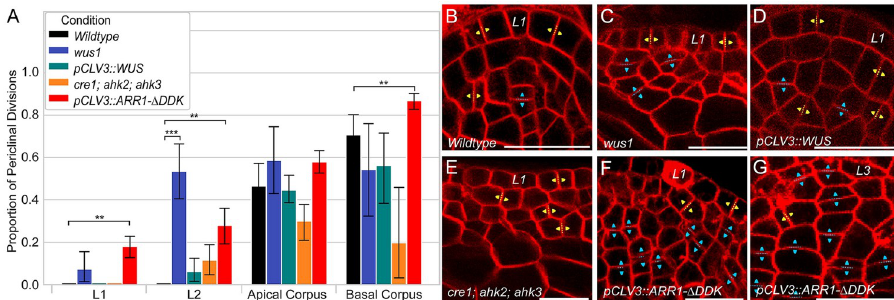
Fig 4. Layer-specific organization of cell division plane orientation. (A) Periclinal and anticlinal divisions were quantified by cell layer on a minimum of 10 SAMs (see S1 Appendix for details). Significance tests were performed using independent t-tests. Asterisks indicate significance at the following levels: �� (p � 0.01), ��� (p � 0.0001). Higher magnification median longitudinal section from Fig 2 showing (B) wildtype [l er ], (C) wus1–1 , and (E) cre1–12; ahk2–2;ahk3–3 vegetative meristems. 48 hour Dex induction of (D) ectopic misexpression of WUS [pCLV3::LhG4; 6xOP::eGFP-WUS-GR] and (F) ectopic misexpression of CK signaling [pCLV3::LhG4; 6xOP::ARR1 - Δ DDK-GR] . (G) Characteristic “strips” of cells formed by repeated periclinal divisions in the Basal corpus of ectopic misexpression of CK experiments. (B-G) Positioning of new cell walls between speculated daughter cells after recent divisions are annotated in yellow arrowheads for anticlinal cell division and cyan arrowheads for periclinal cell division. Scale bar = 20 μ